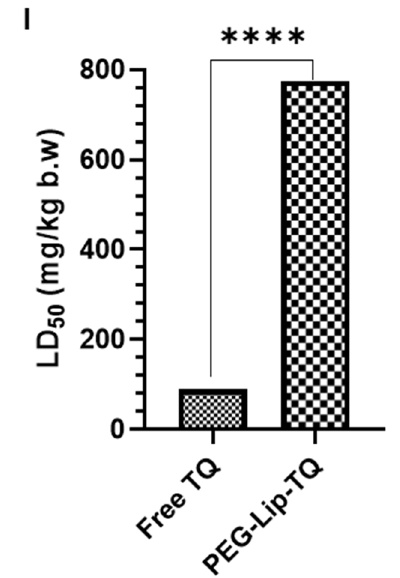
Figure 8. Effect of free TQ and PEG-Lip-TQ on body weight and LD 50 ( A ) Average body weight by free TQ during the experiment period in phase 1, ( B ) Average body weight of surviving animals by free TQ after 14 days in phase 1, ( C ) Average body weight by free TQ during the experiment period in phase 2, ( D ) Average body weight of surviving animals by free TQ after 14 days in phase 2, ( E ) Average body weight by PEG-Lip-TQ during the experiment period in phase 1, ( F ) Average body weight of surviving animals by free PEG-Lip-TQ after 14 days in phase 1, ( G ) Average body weight by PEG-Lip-TQ during the experiment period in phase 2, ( H ) Average body weight of surviving animals by free PEG-Lip-TQ after 14 days in phase 2, ( I ) LD 50 of free TQ and PEG-Lip-TQ. The values are expressed as mean ± SE of three independent experiments. * Significant difference between the treated groups, p -value < 0.05, **** Significant difference between the treated groups, p -value < 0.0001.